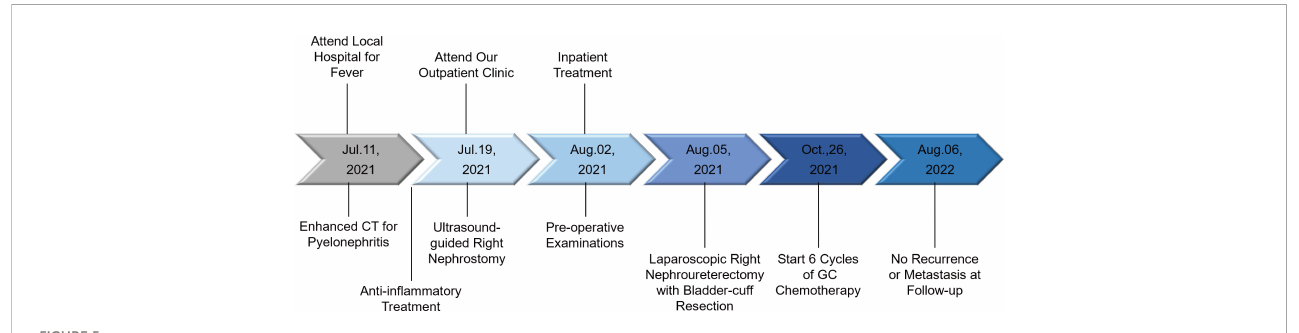
FIGURE 5 Treatment